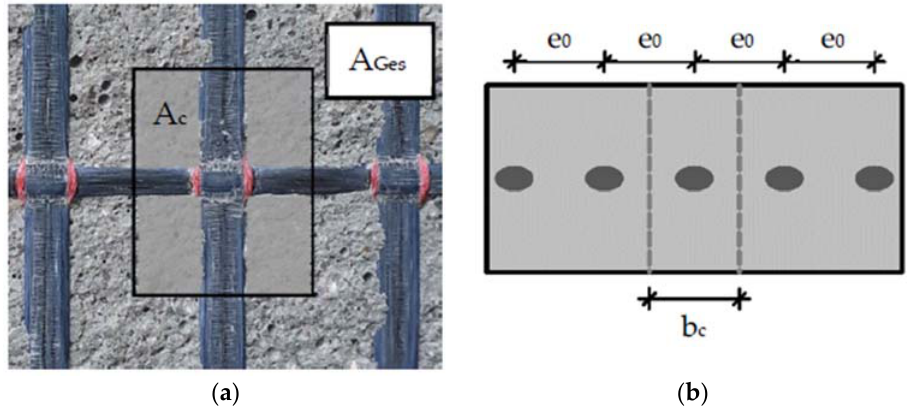
Figure 4. ( a ) Effective concrete area in the textile plane (A c ) per fiber strand and total area in the textile plane per fiber strand (A Ges = A c + A textile ); ( b ) the concrete width per fiber strand (b c ) is equal to the center-to-center distance of the fiber strands (e 0 ).